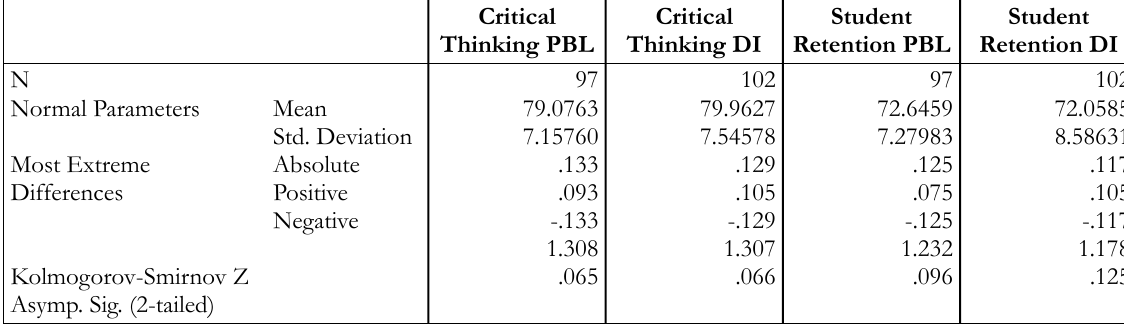
Table 9. One-Sample Kolmogorov-Smirnov Test